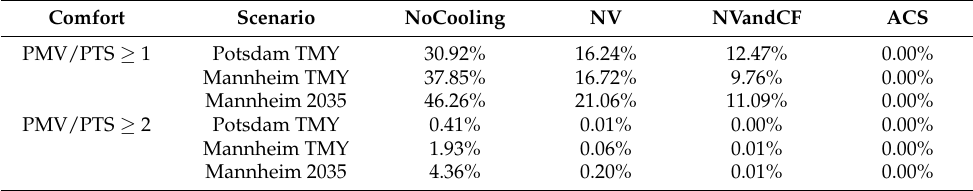
Figure 8. Cumulative PMV (ACS) and PTS (NoCooling, NV, NVandCF) values for all climate scenarios, using the ATHB model. Table 14. Percentage of discomfort hours for PMV (ACS) and PTS (NoCooling, NV, NVandCF) using the ATHB model, values greater than +1 and +2 for different locations and climatic scenarios.